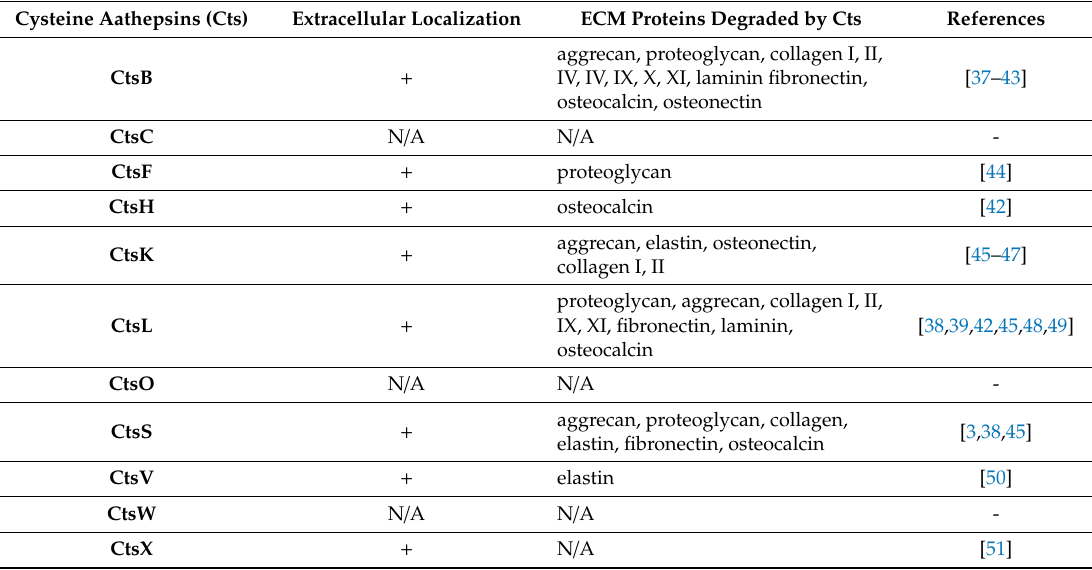
Table 1. Extracellular Cts and their extracellular matrix (ECM)